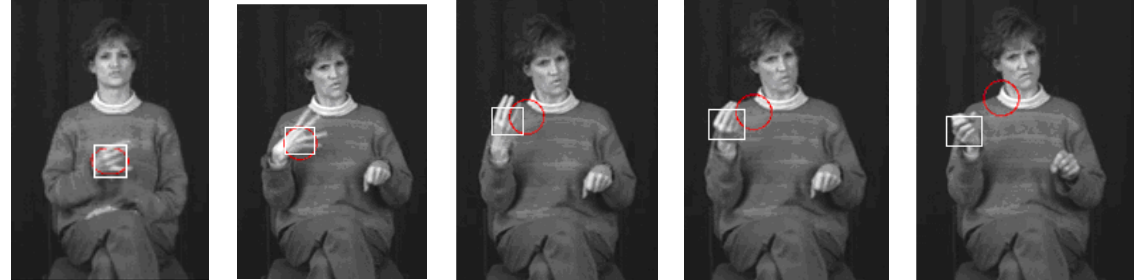
Figure 7. Hand tracking for the usual image by applying the combination of mean shift and motion detection